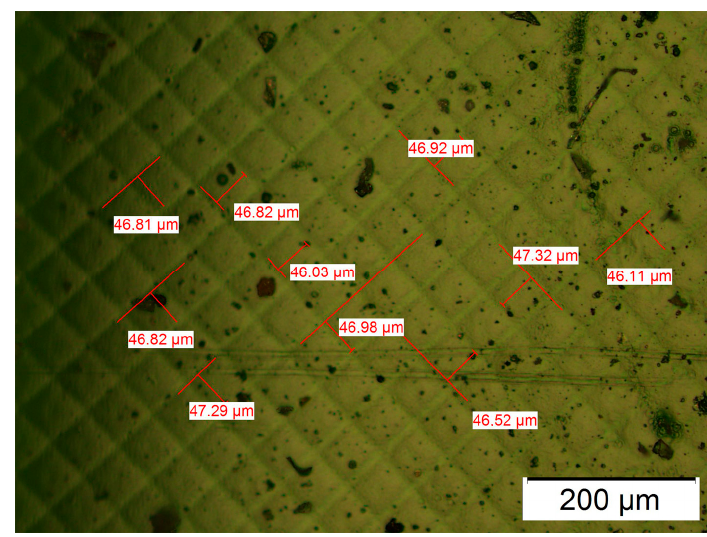
Figure 6. Visijet FTX. Pixilation of DLP part. Materials 2017 , 10 , 64